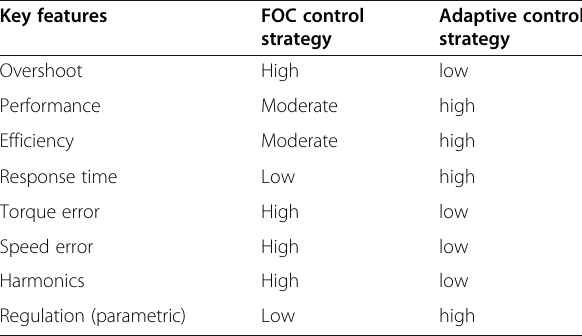
Table 3 Critical points of the applied control strategies Key features